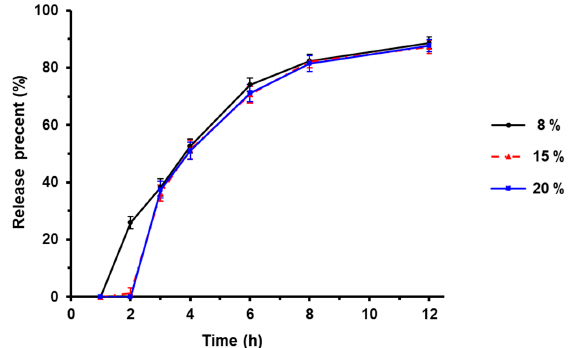
Figure 2. Effect of barrier layer weight on drug release ( n = 3).